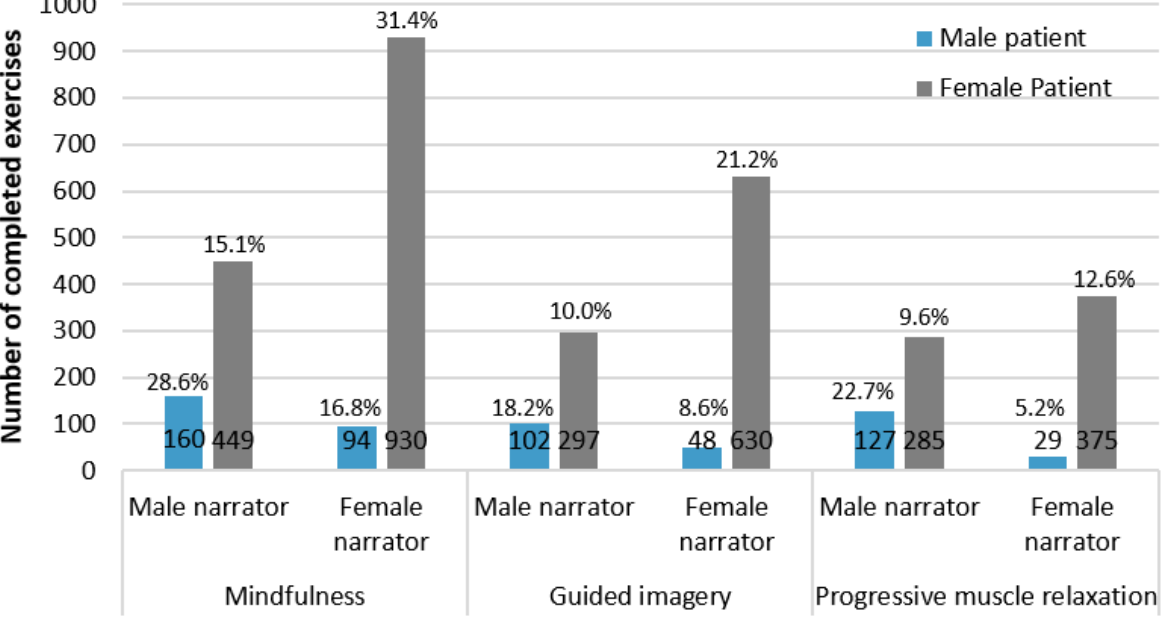
Figure 3. Completed exercises (3526) of all patients (N=100) over 20 weeks by type (mindfulness meditation, guided imagery, and progressive muscle relaxation), gender of patient (male and female), and sex of narrator (male and female). Percentages refer to the total number of exercises per